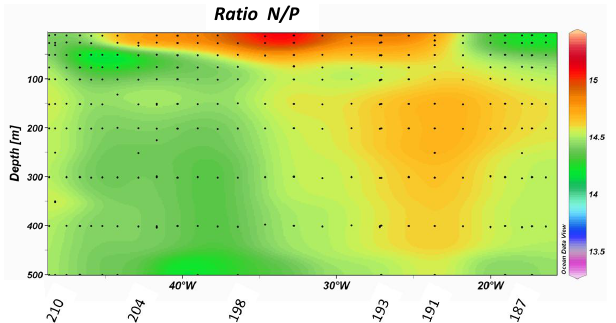
Fig. 8b. Section plot of N:Si ratio along the Weddell Sea transect in the upper 500m, for that region where a winter water Layer is observed and a removal ratio is calculated ( ∼ 17– ∼ 48.5 ◦ W). The locations of the stations where DFe data is available and a nutrient removal is calculated are